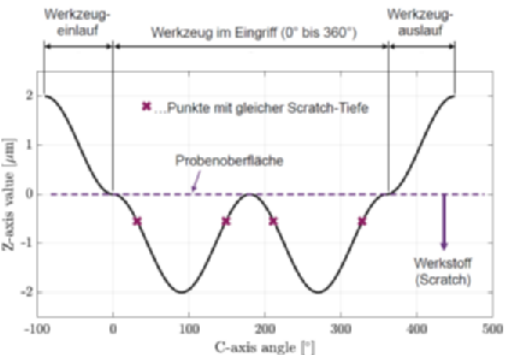
Figure 1: Standardized procedure for determining the critical chip thickness by placing a rotary indentation with varying chip thickness into the specimen surface.